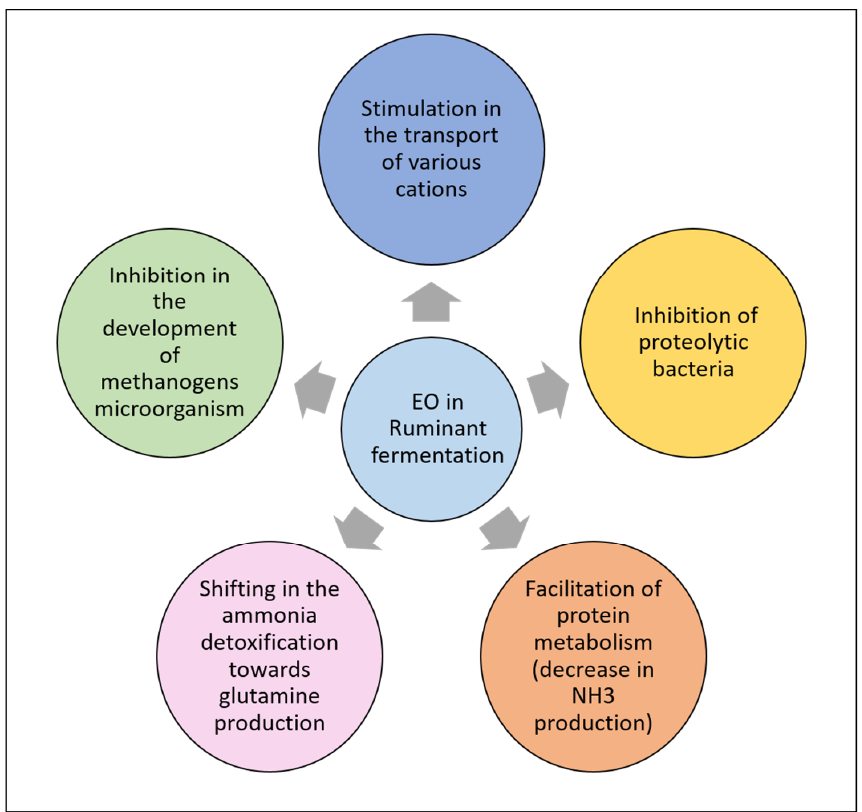
Figure 5. Essential oils in ruminant fermentation